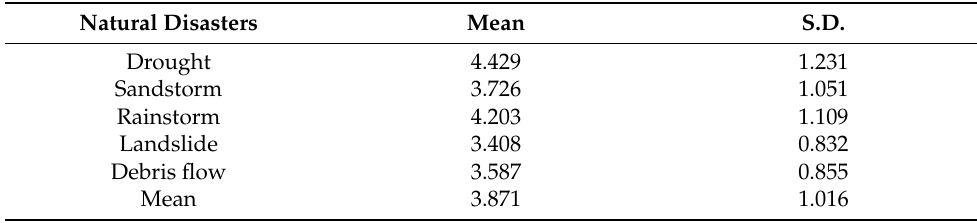
Table 2. Descriptive statistics of natural